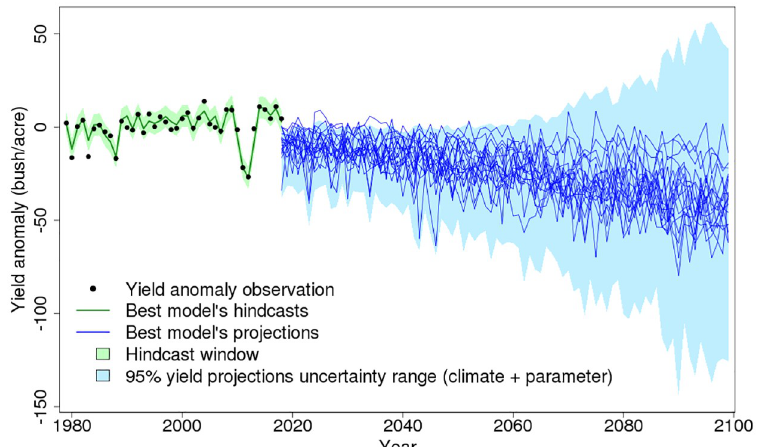
Fig 2. Annual mean yield hindcasts and projections under different methodological choices. The black dots represent the area-weighted average annual yield observations. The green line is the best estimate of yield hindcast based on the model with the least cross-validation error. The deep blue lines are best estimates of this model for 18 different climate projections. Adding the effects of considered parameter uncertainty allows a pre-calibration to cover 95% of the observed yield data (light green area). The total effects of the considered uncertainties (climate forcings and parameters) expand the projection with a much wider 95% uncertainty range (light blue area).